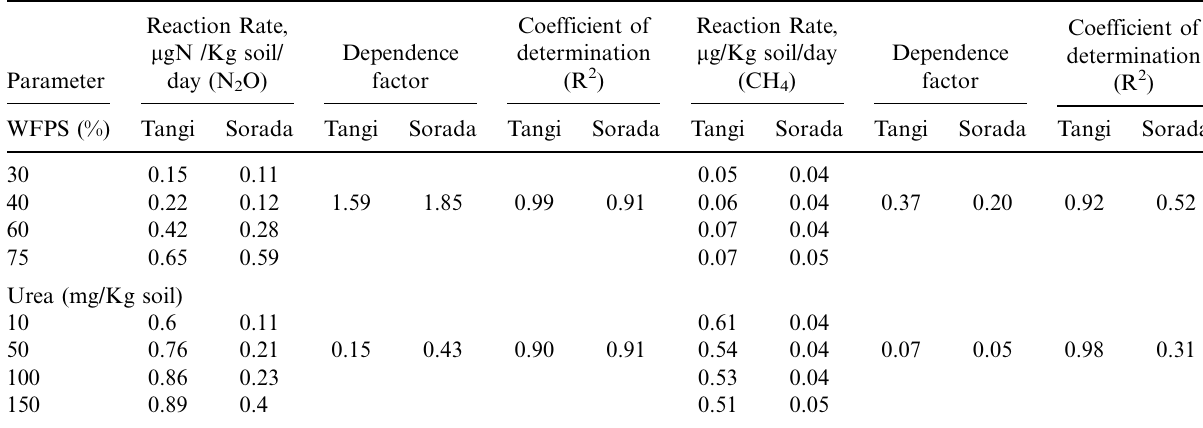
Table 3. Emission rates of nitrous oxide (N 2 O) and CH 4 with dependence factor during incubation (Conditions: Temperature (cid:3) 37 8